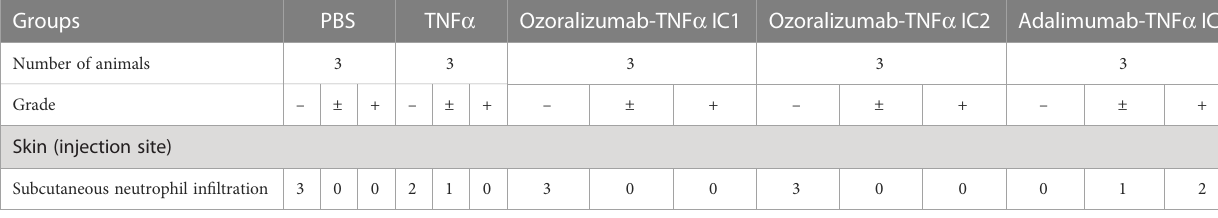
TABLE 1 Histopathologic fi ndings in a mouse model of immune complex (IC)-induced subcutaneous in fl ammation. Groups PBS TNF a Number of animals